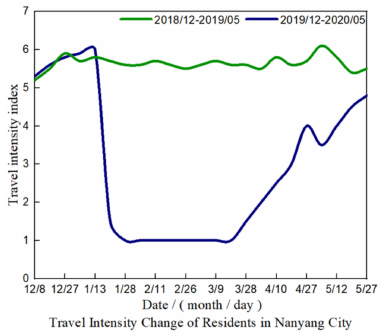
Figure 11. Intra city travel in lockdown